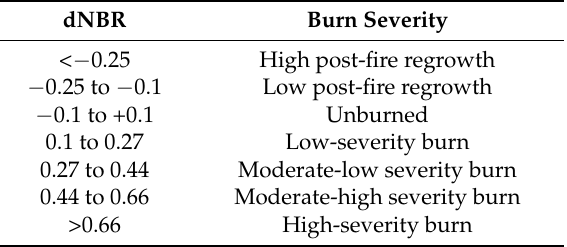
Table 2. Fire severity classes assigned to dNBR ranges (from